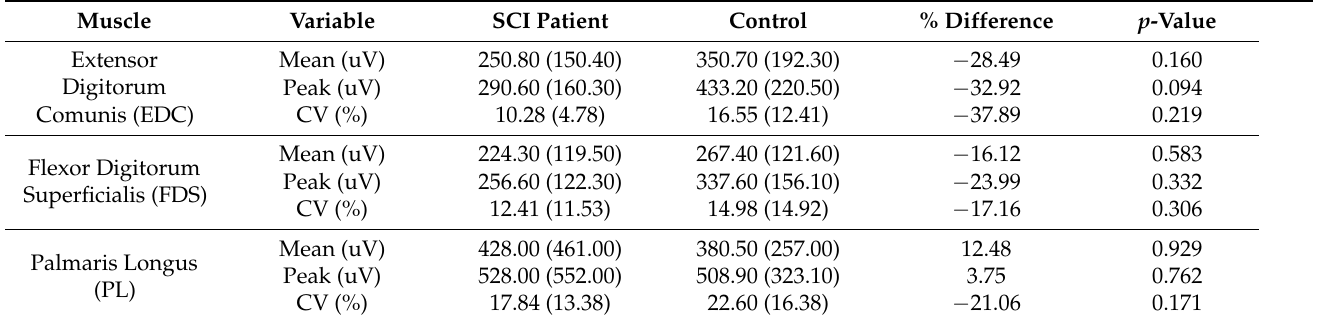
Table 5. Descriptive statistics and p -values of individual muscles associated with the finger joint between the SCI group and the control